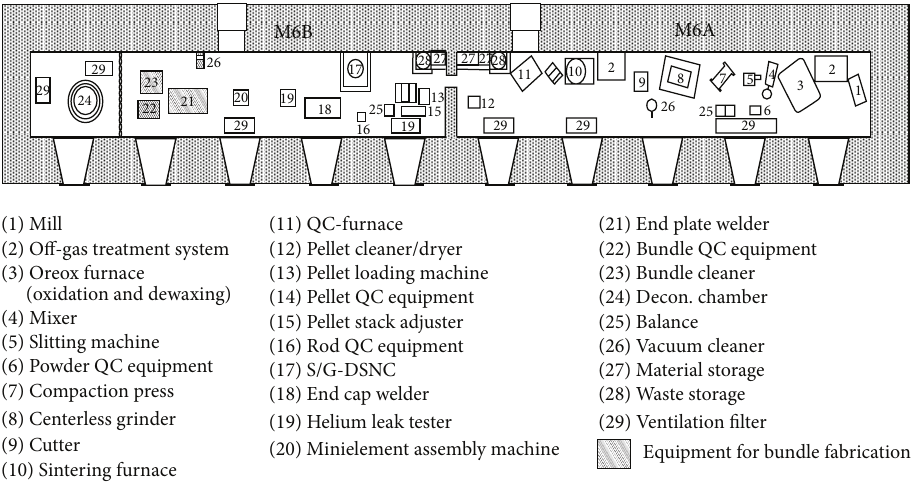
Figure 1: Layout of the remote process equipment for nuclear fuel fabrication in DFDF.